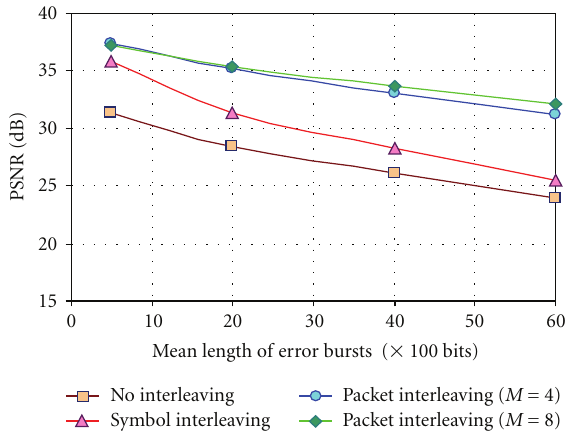
Figure 6: Relationship between display deadline and the number of interleaved packets in a group.